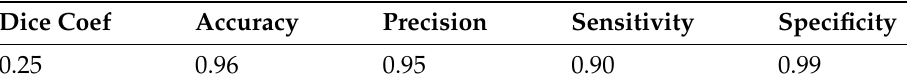
Table 2. Summary of the tumor identification performance.